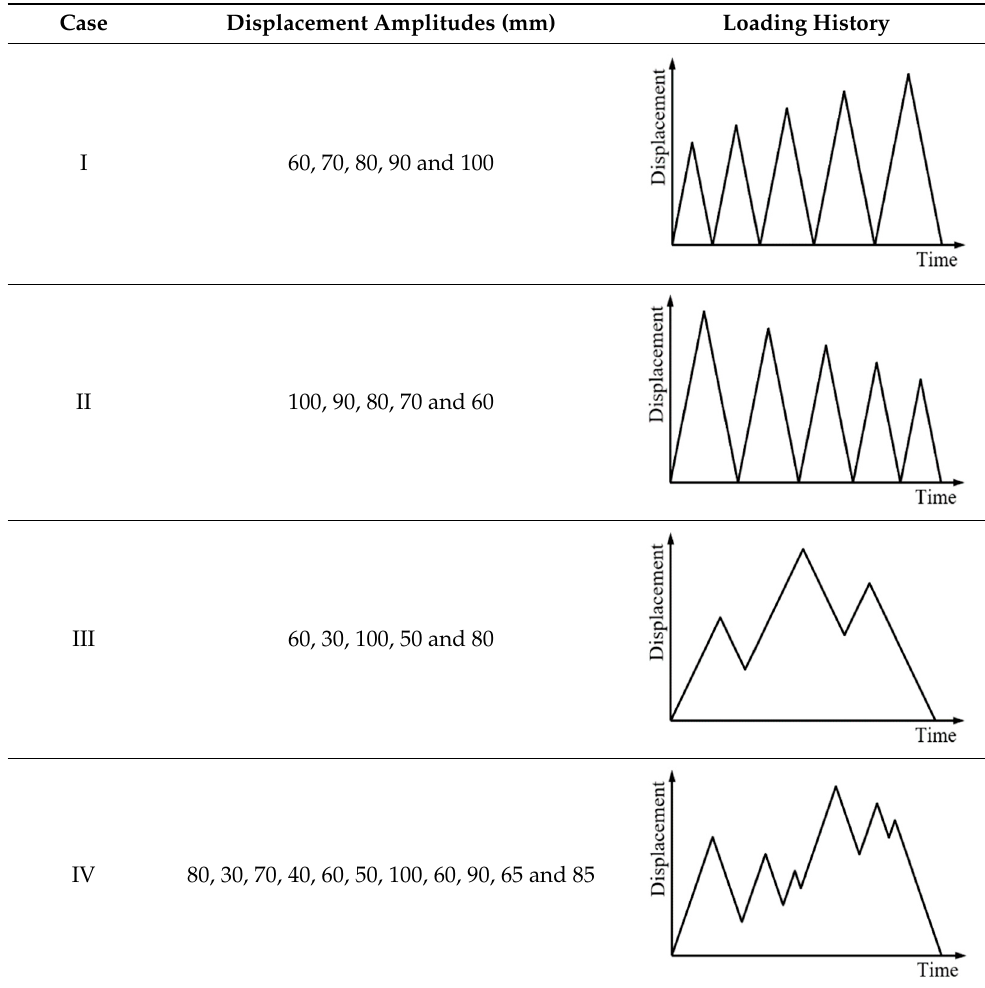
Figure 8. Tension tests of the SMA helical spring specimens: ( a ) SMA-S1; ( b ) SMA-S2; ( c ) SMA-S3; ( d ) SMA-S4. Table 4. Loading cases for the SMA spring specimens.